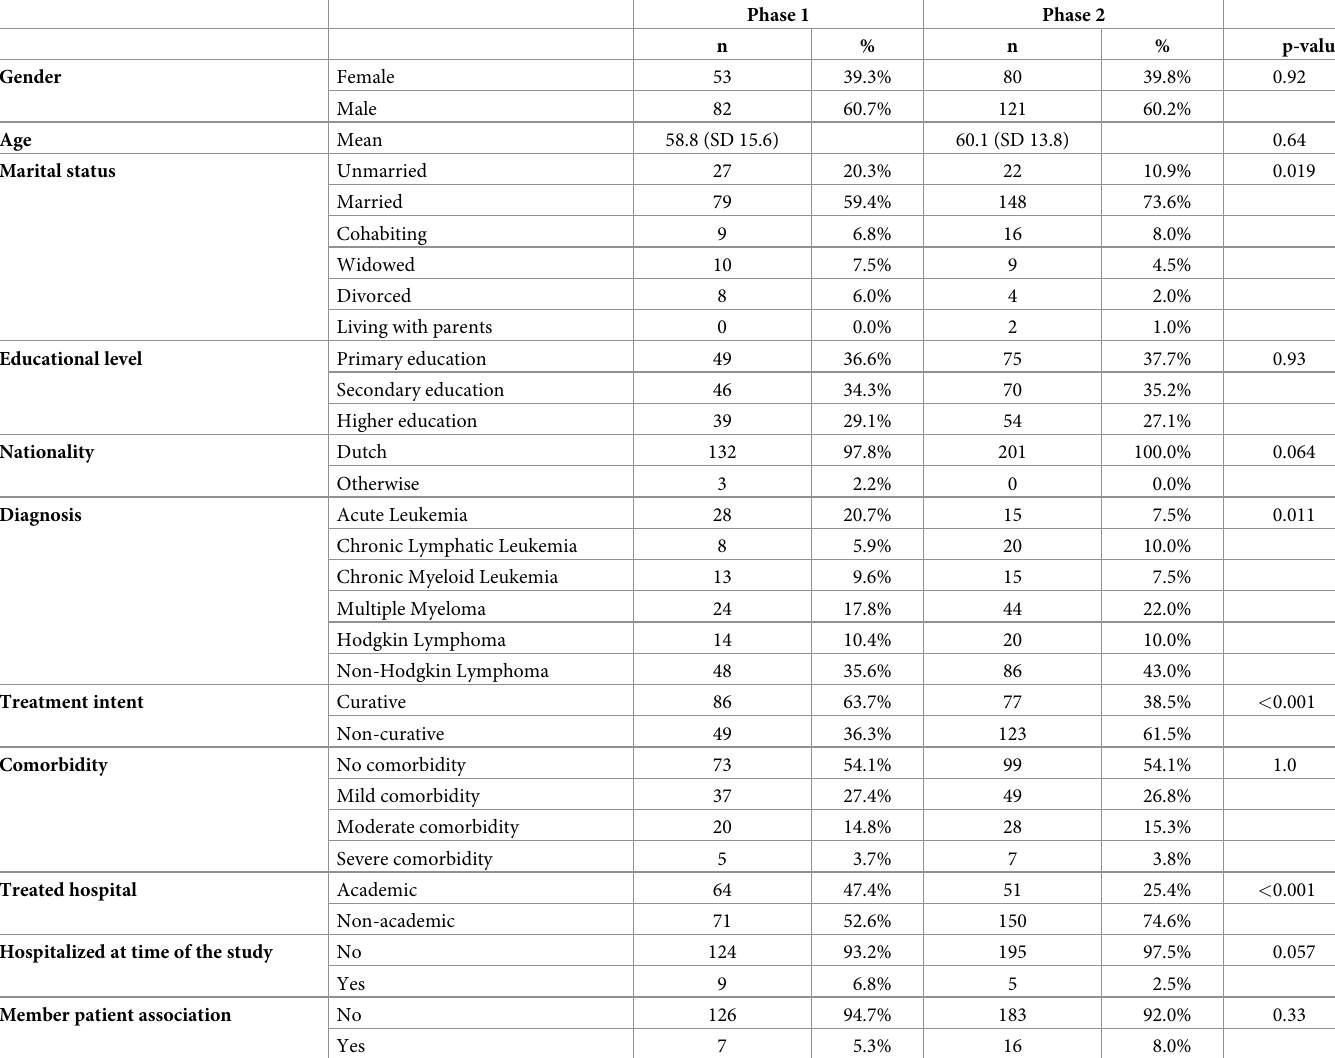
Table 1. Overview of sociodemographic and clinical characteristics of patients of phase 1 (n = 135) and phase 2 (n = 201).